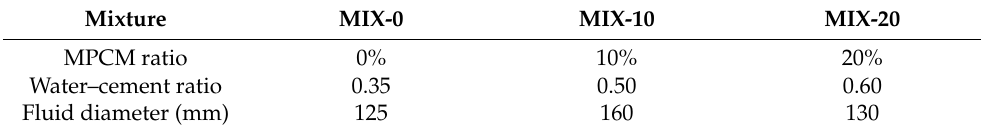
Table 2. Fluidity test results.